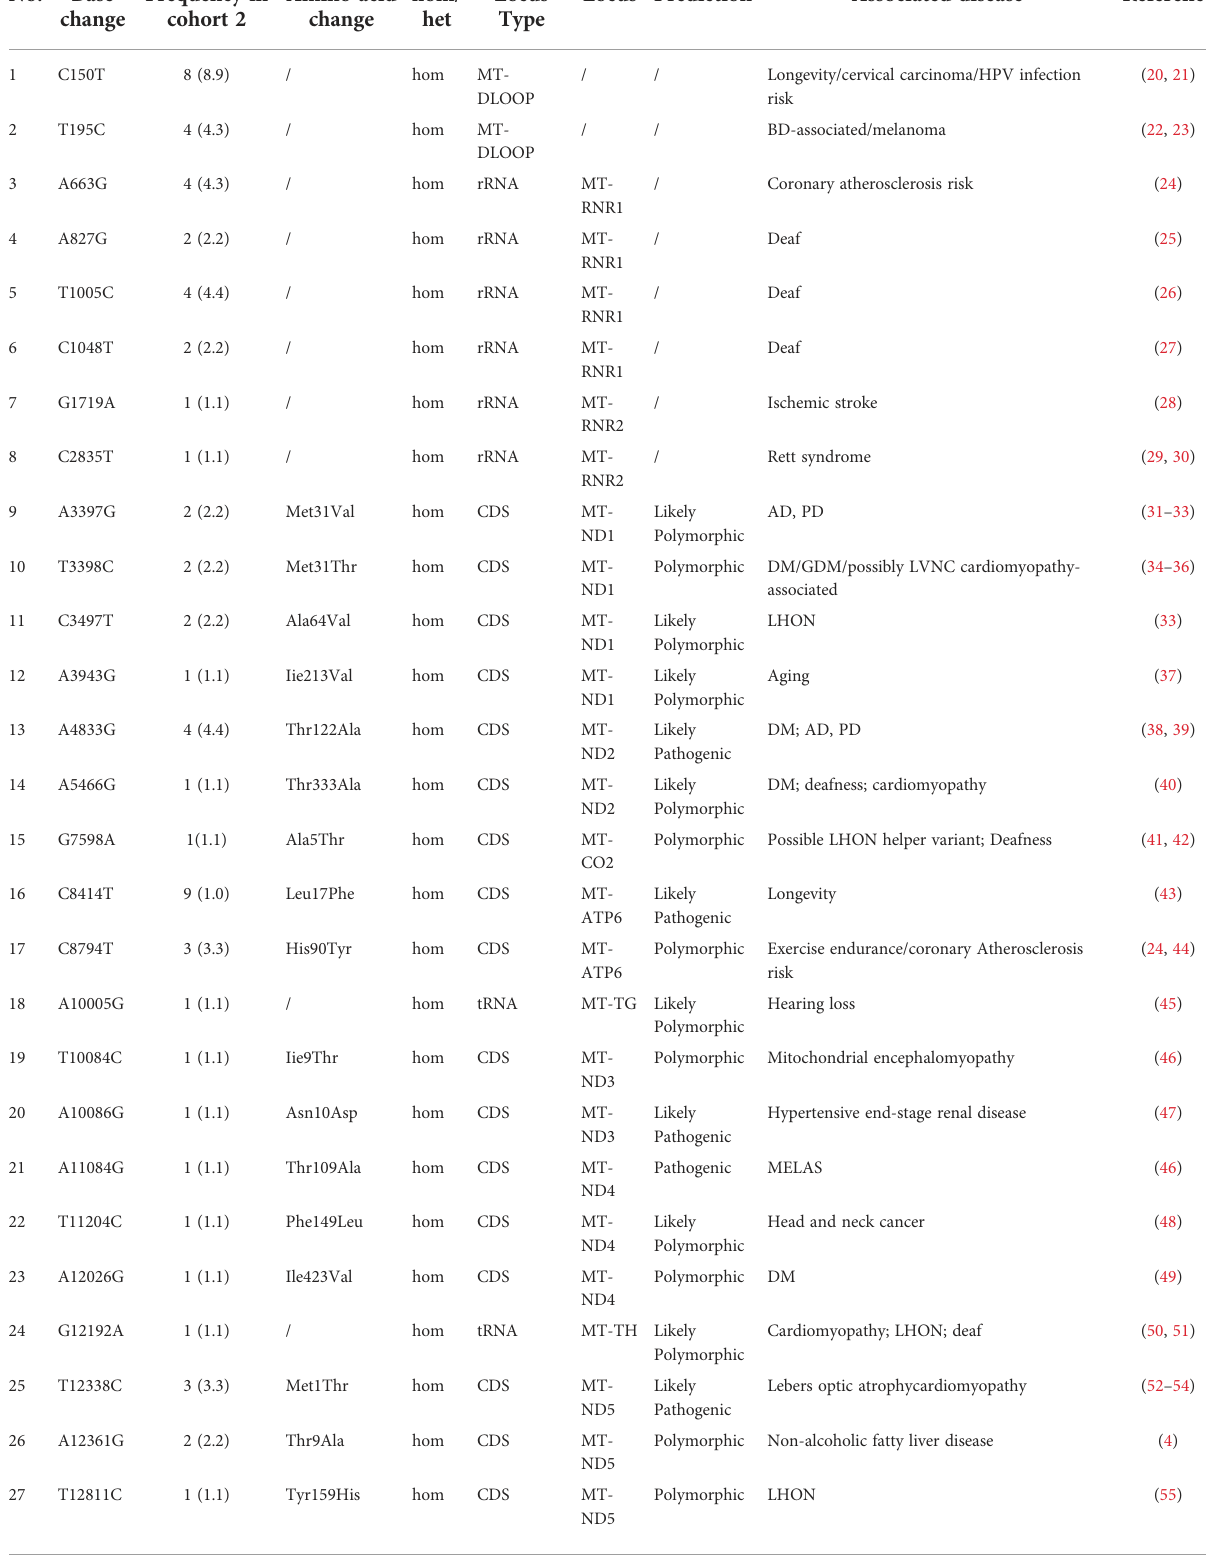
TABLE 3 The rare mitochondrial DNA (mtDNA) variants from cohort 2 possibly associated with mitochondrial disease